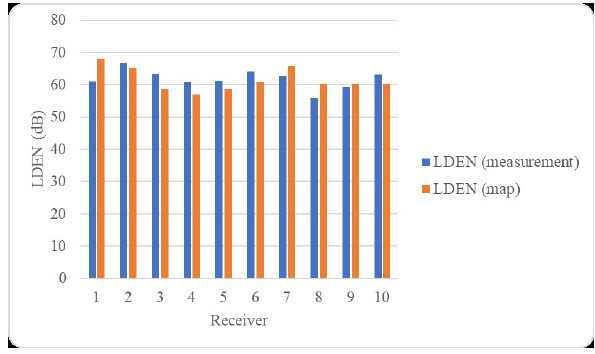
Figure 9: Differences between measured and calculated values for LDEN in the Port of Thessaloniki yearly report [15]